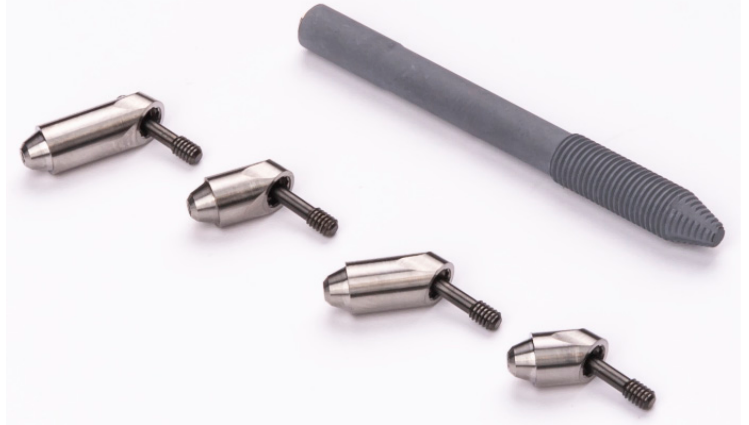
Figure 1. Study implant (NobelZygoma 0 ◦ ; Nobel Biocare) and study abutment (Multi-unit abut- ments of 45 and 60 degrees and 6 mm of height; Nobel